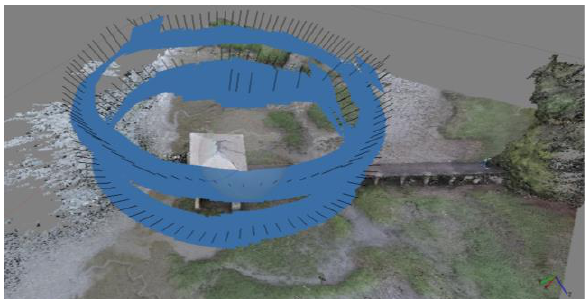
Figure 3. Camera positions of frames extracted from HD Video collected by Phantom 4